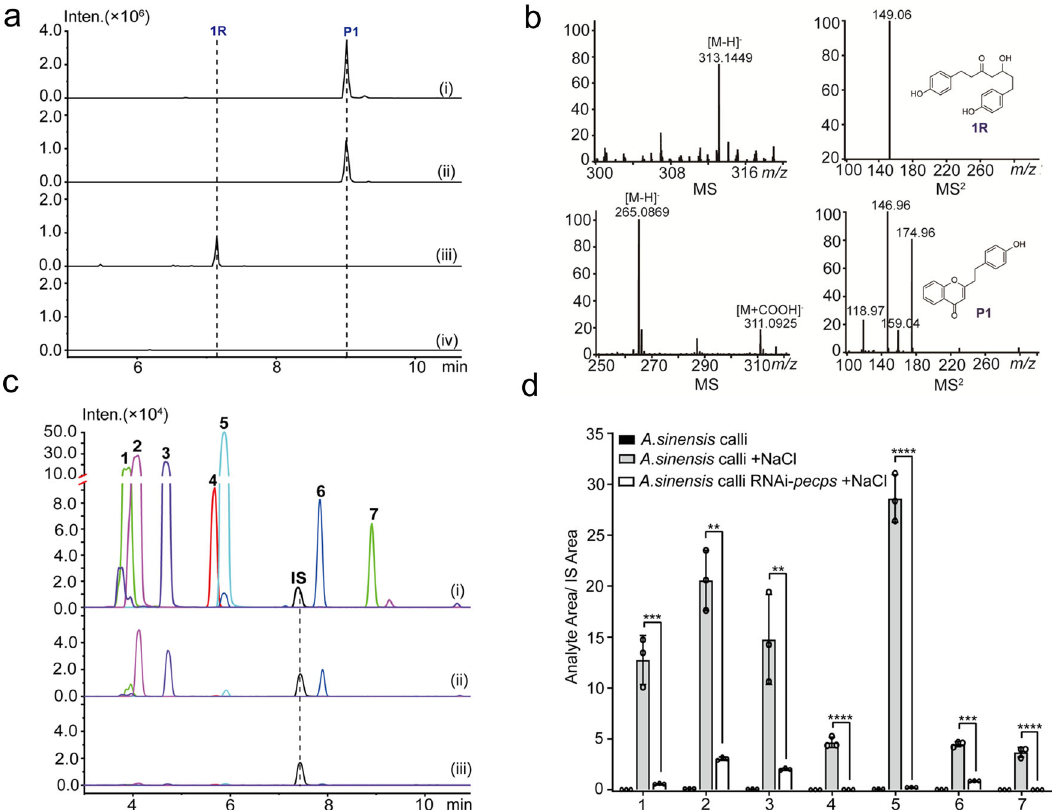
Fig. 3 Determination of the in vivo biochemical function of PECPS by transient expression of PECPS in N. benthamiana and knockdown expression of PECPS in A. sinensis calli . a MS chromatograms (EIC) of 5-hydroxy-1,7-bis(4-hydroxyphenyl)heptan-3-one ( 1R ) and 2-(4-hydroxyphenylethyl)-4 H - chromen-4-one ( P1 ) accumulated in N. benthamiana leaves: (i) standard of P1 ; (ii) leaves in fi ltrated with benzoyl-CoA and Agrobacterium harboring pCAMBIA1300-35S- pecps ; (iii) Leaves in fi ltrated with Agrobacterium harboring pCAMBIA1300-35S- pecps ; (iv) leaves in fi ltrated with Agrobacterium harboring pCAMBIA1300-35S vector. b MS and MS 2 spectra of 1R and P1 . c MS chromatograms (EIC) of the major PECs 1 – 7 (structures could be found in Supplementary Fig. 22) accumulated in A. sinensis calli treated by different methods: (i) treated with 150 mM NaCl; (ii) knockdown PECPS expression and treated with 150 mM NaCl; (iii) healthy calli. d The relative contents (1,5-diphenylpentane-1,3-dione was implemented as internal standard, IS ) of PECs 1 – 7 accumulated in different A. sinensis calli. Data represent the mean ± SD ( n = 3). Statistical analysis was performed with unpaired two-tailed Student ’ s t-tests. Signi fi cance is shown with asterisks: **** p < 0.0001, *** p < 0.001, ** p < 0.01. Exact p -values and source data are provided in the source data fi